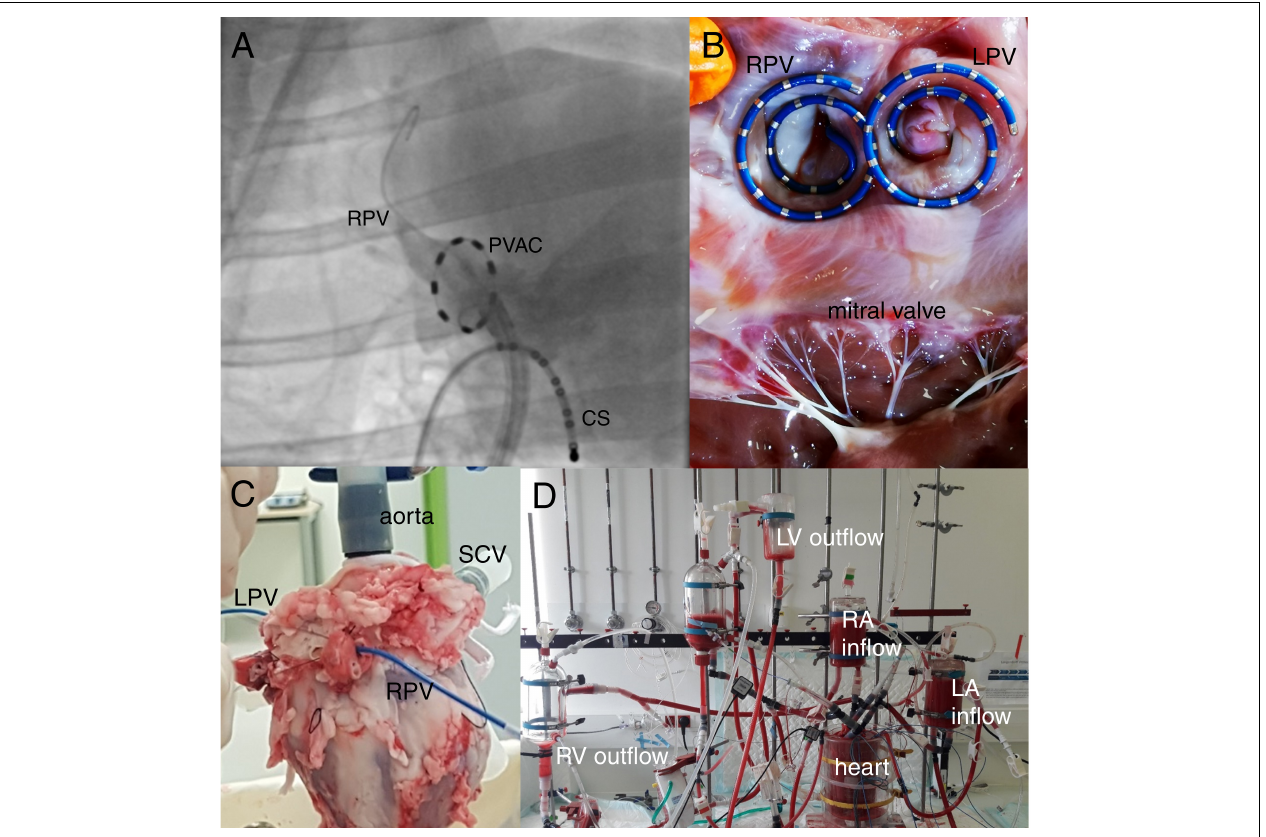
FIGURE 1 | In vivo and ex vivo methodology. (A) Fluoroscopic image (right anterior oblique view of 41 ◦ ) with circular ablation catheter (“PVAC”) positioned in the right pulmonary vein (RPV) of a sheep. A catheter is placed in the coronary sinus (CS) for anatomical reference. (B) Diagnostic double-helix catheters positioned in the RPV and right pulmonary vein (LPV) of the explanted heart. The photo is taken after ex vivo experimentation. (C) The PVs were tied off with the diagnostic catheters in place. (D) The heart was connected to a four-chamber working heart setup and perfused with an autologous blood:Tyrode’s solution. A bucket with perfusion solution was placed around the heart. The atria were each connected to a reservoir “preload” chamber, and LA pressure was modulated by changing the height of the left atrium (LA) reservoir chamber. LV: Left ventricle. RA, right atrium; RV, right ventricle; SCV, superior caval